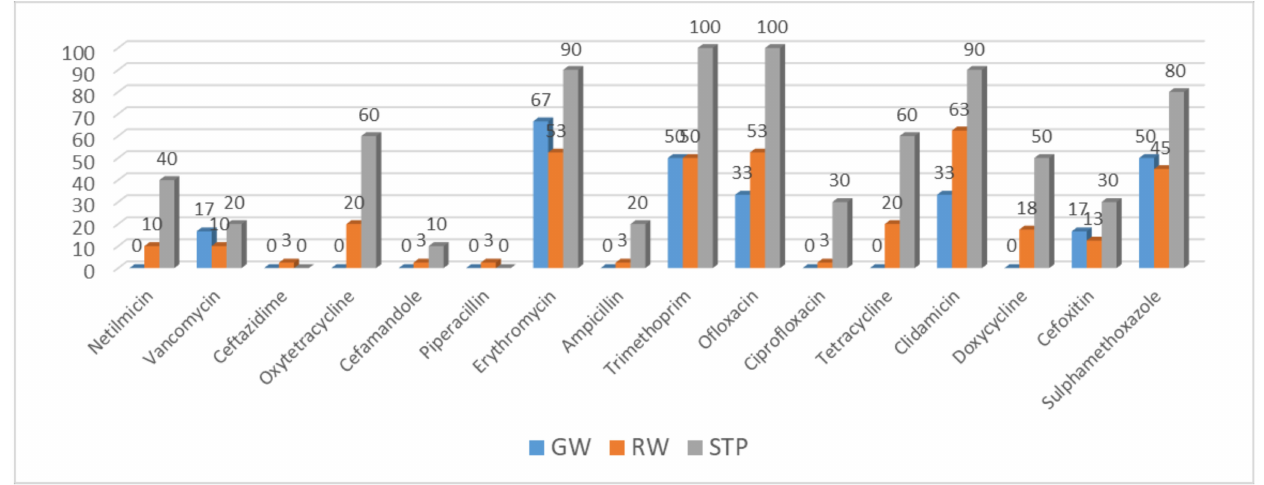
Figure 2. Frequency of antibiotic detection in various types of water